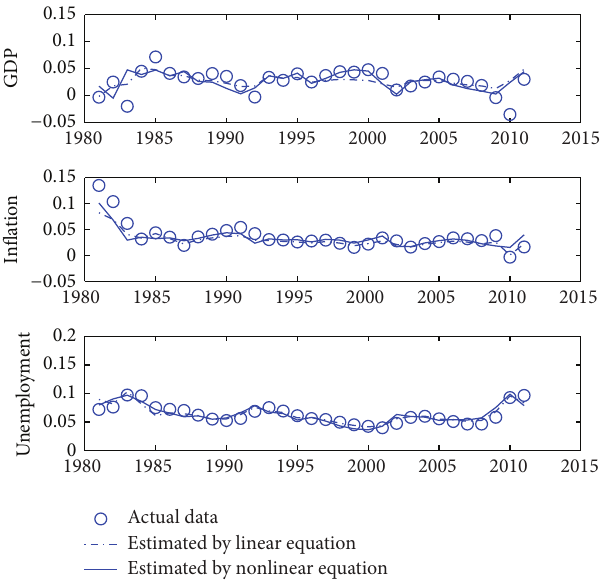
Figure 2: The actual and estimated data of the GDP, inflation, and unemployment by the linear and nonlinear models with ℎ = 0.65